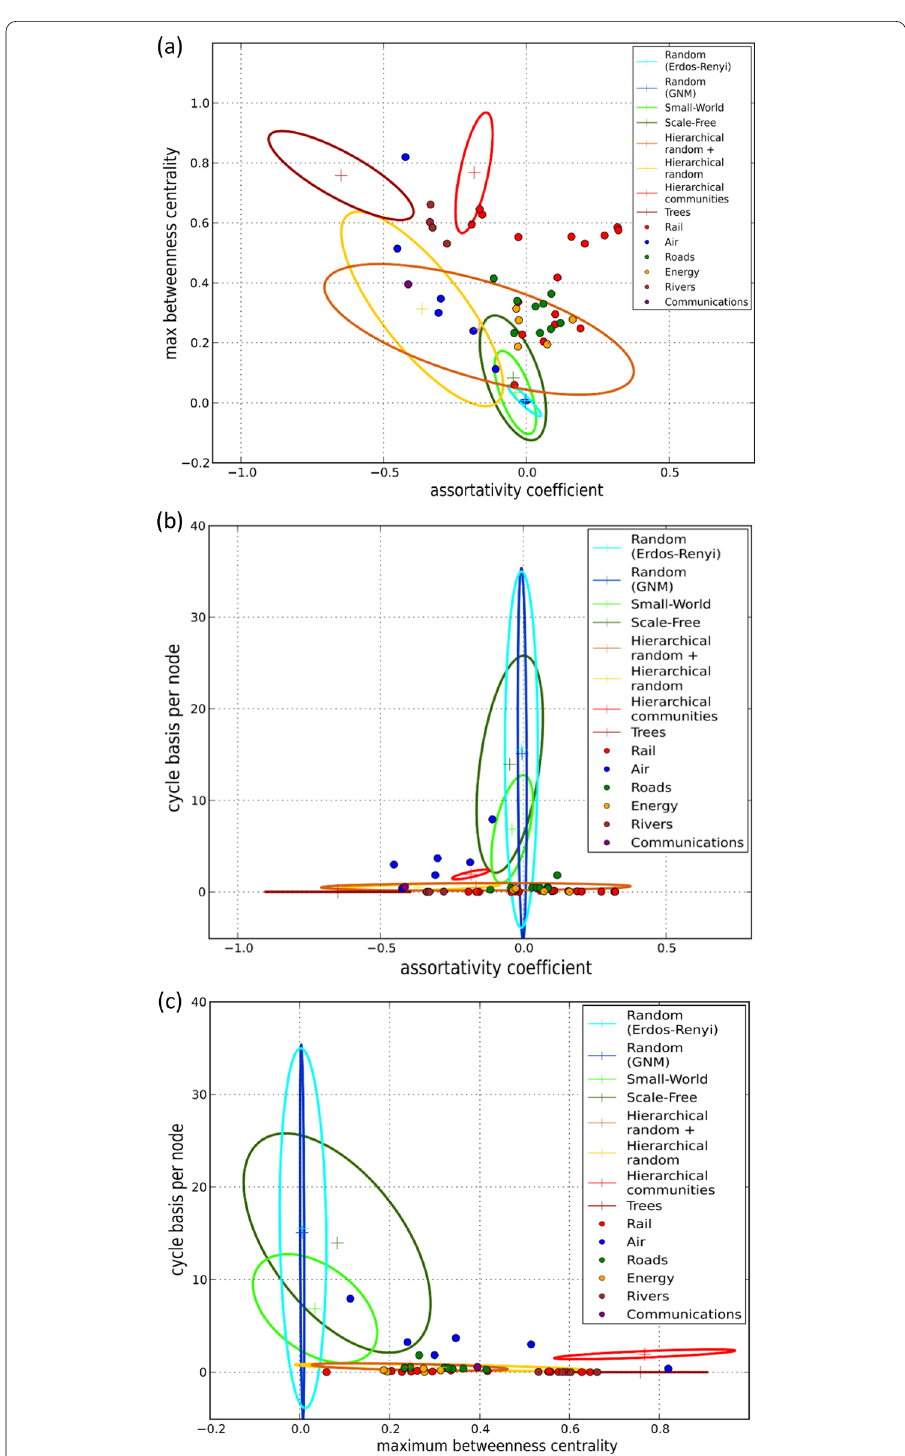
Fig. 4 Multi-variate plots comparing the relationships between the three pair-wise combinations of graph metrics (AC, MBC and CB), with standard deviation ellipses showing the distribution of values for each of the eight graph models and values for each individual spatial infrastructure network located using point